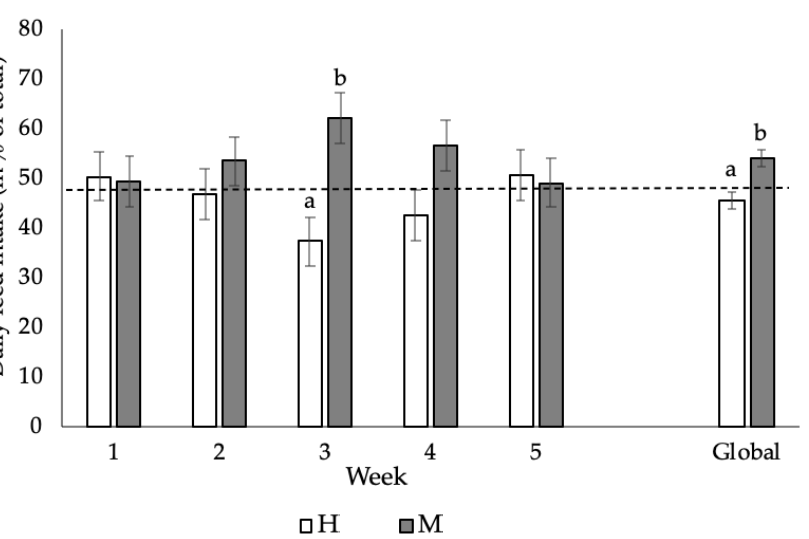
Figure 1. Daily feed intake (mean and standard error) of growing rabbits fed the M diet (following current nutritional recommendations for growing rabbits, including 8.1, 5.8 and 6.9 g/kg dry matter (DM) of total lysine, sulphur amino acids and threonine, respectively) and the H diet (with higher levels of total lysine, sulphur amino acids and threonine: 9.4, 6.6 and 7.8 g/kg DM, respectively) during the five-week choice-feeding trial, as well as during the whole growing period (global). a,b Means within different letters were significantly different ( p < 0.05). Week 1 (28–35 days), week 2 (35–42 days), week 3 (42–49 days), week 4 (49–56 days) and week 5 (56–63 days).